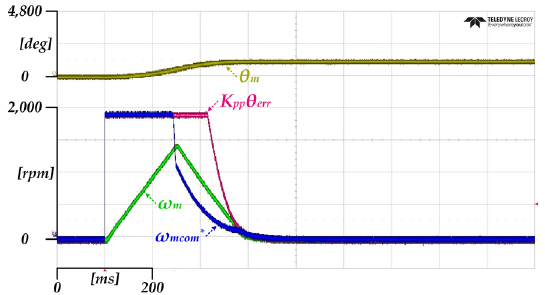
Figure 10. The position controller output, compensated output and actual velocity of the proposed method.